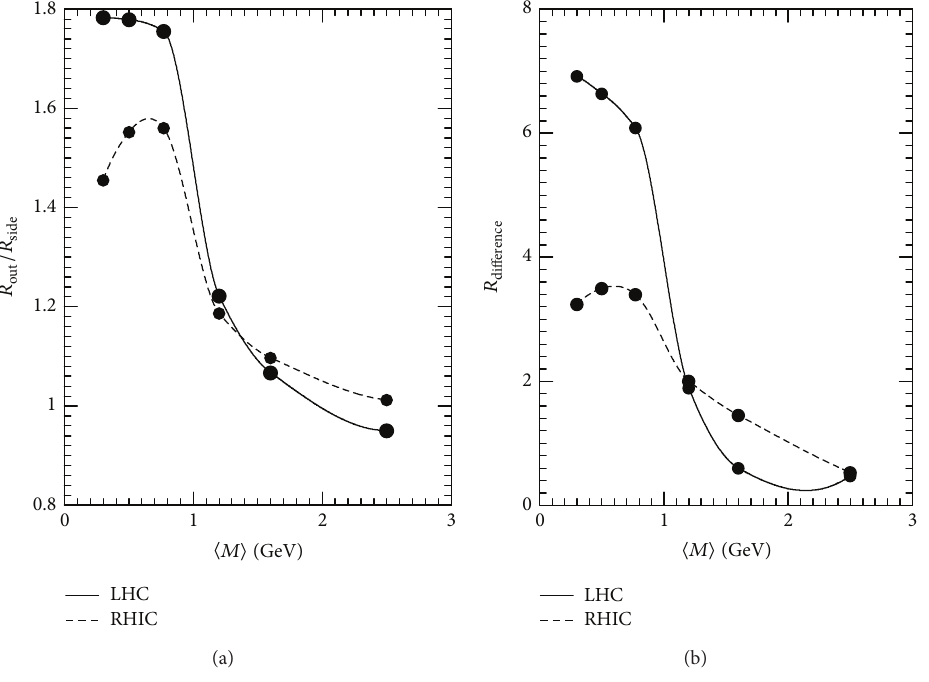
/𝑅 (a) and the difference √𝑅 2 out side